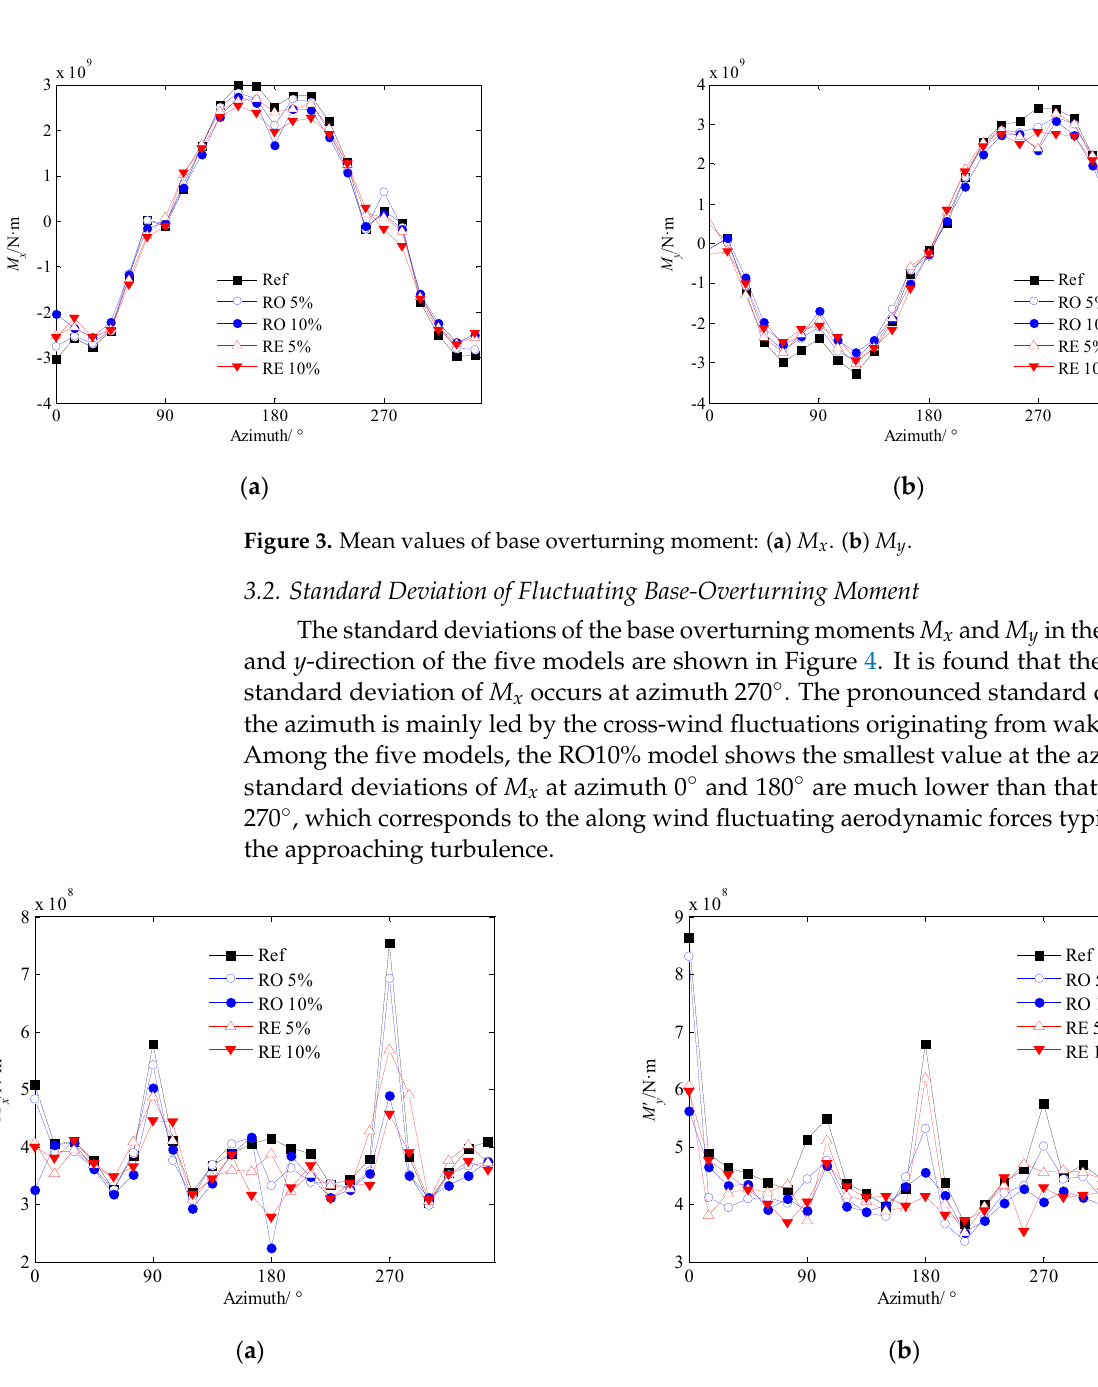
Figure 4. Standard deviation of base overturning moment: ( a ) the x -direction. ( b ) the y -direction.